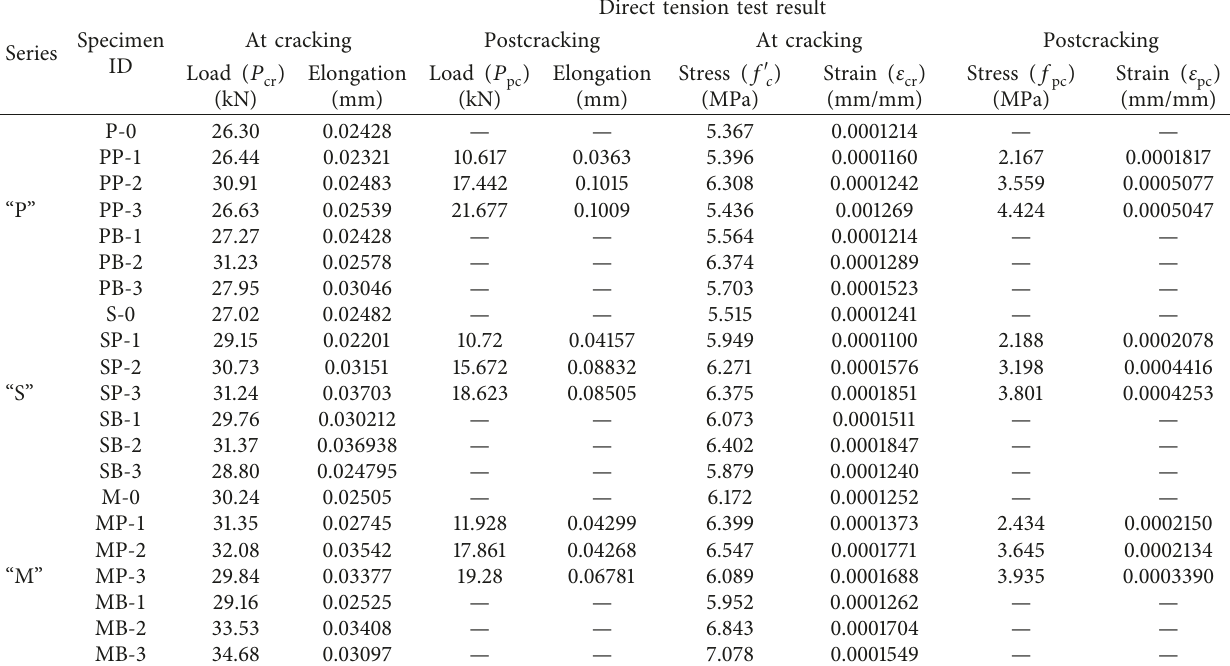
Table 4: Tension test results at 28